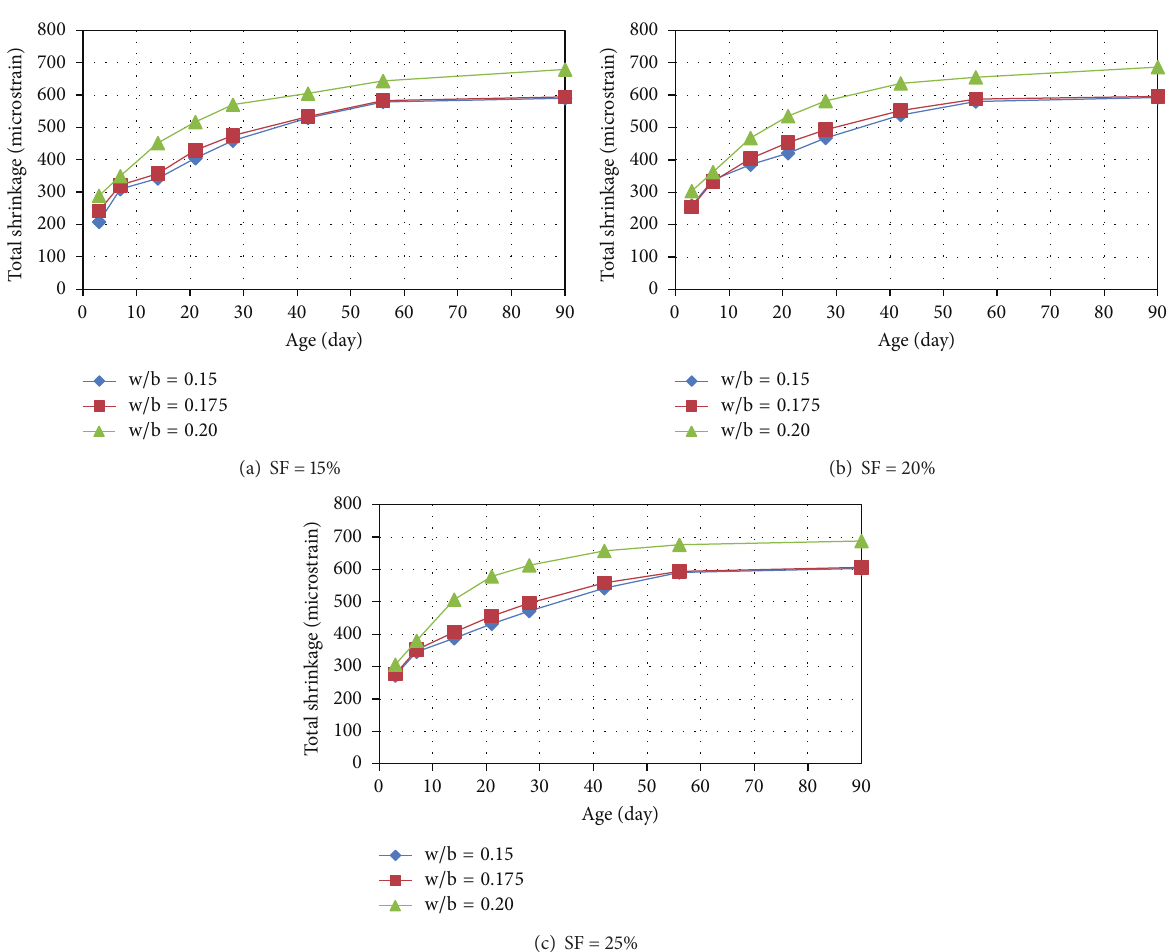
Figure 3: Variation of total shrinkage of RPC mixtures (having cement content of 1100kg/m 3 ) with